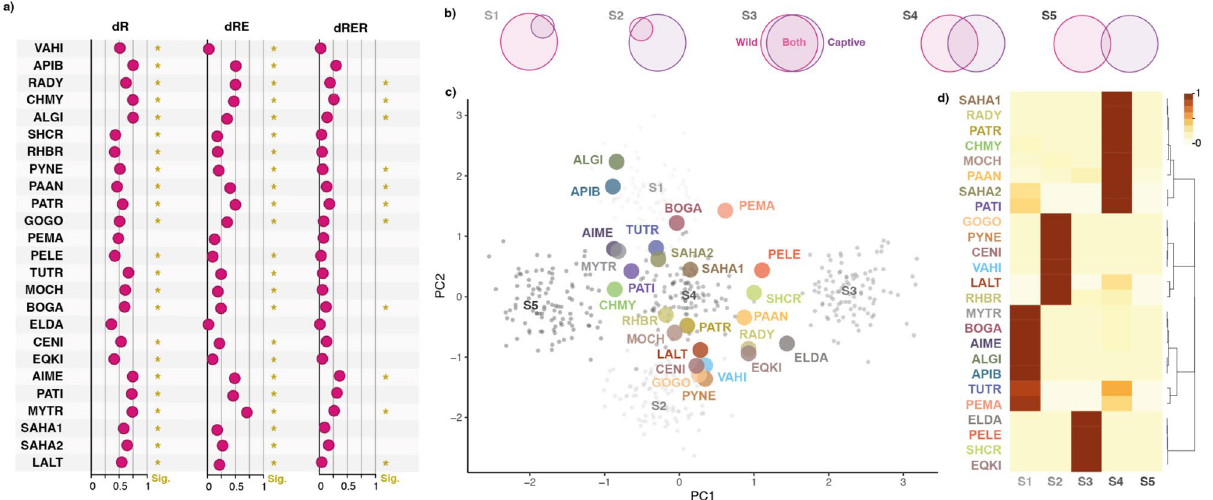
Figure 2. Compositional differences of the gut microbiota between wild and captive vertebrate populations. ( a ) Compositional dissimilarity values between captive and wild populations for the different diversity metrics analysed. Stars indicate whether dissimilarities were significant according to the null models. ( b ) Visual representation of the five scenarios of microbiota variation. “S1” depicts the gut microbiota of captive animals as a subset of that of wild counterparts. “S2” describes the opposite scenario in which the gut microbiota of wild animals is a subset of that of captive counterparts. “S3” assumes barely no difference between the gut microbiota of both populations. “S4” defines a a situation in which captive animals recruit a proportional set of microorganisms that is different from that of wild counterparts, yet maintain a considerable overlap. “S5” describes a scenario in which the gut microbiotas of both populations are almost totally different. ( c ) Principal components analysis showing observed microbiota variation in the studied host species (large coloured dots) over simulated data points (small greyscale dots). ( d ) Histogram of posterior probabilities of the contrasted scenarios for each host species, sorted according to hierarchical clustering dendrogram. Abbreviations are explained in Fig.